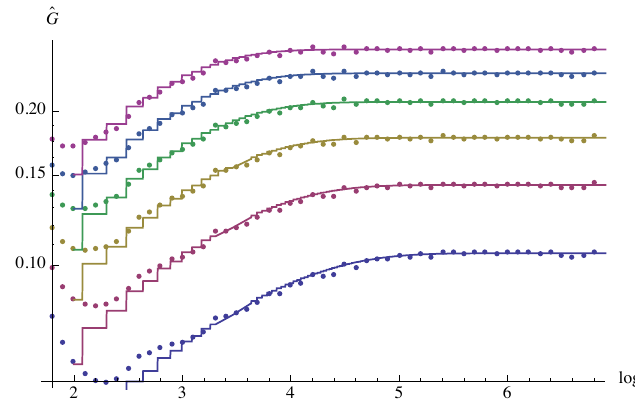
Figure 7 . The estimate (4.18) for the ramp and the plateau with (cid:13) = 2 (solid lines) versus the numerically evaluated progressive time averaged regularized two point function (dots)